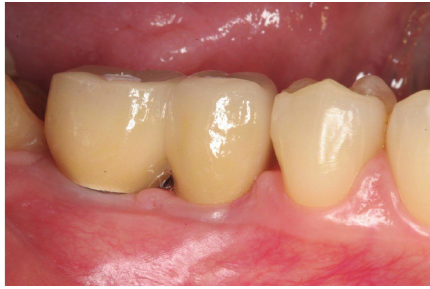
Figure 3: Intraoral view of the implant crowns 8 years after implant placement. Peri-implant soft tissues appear